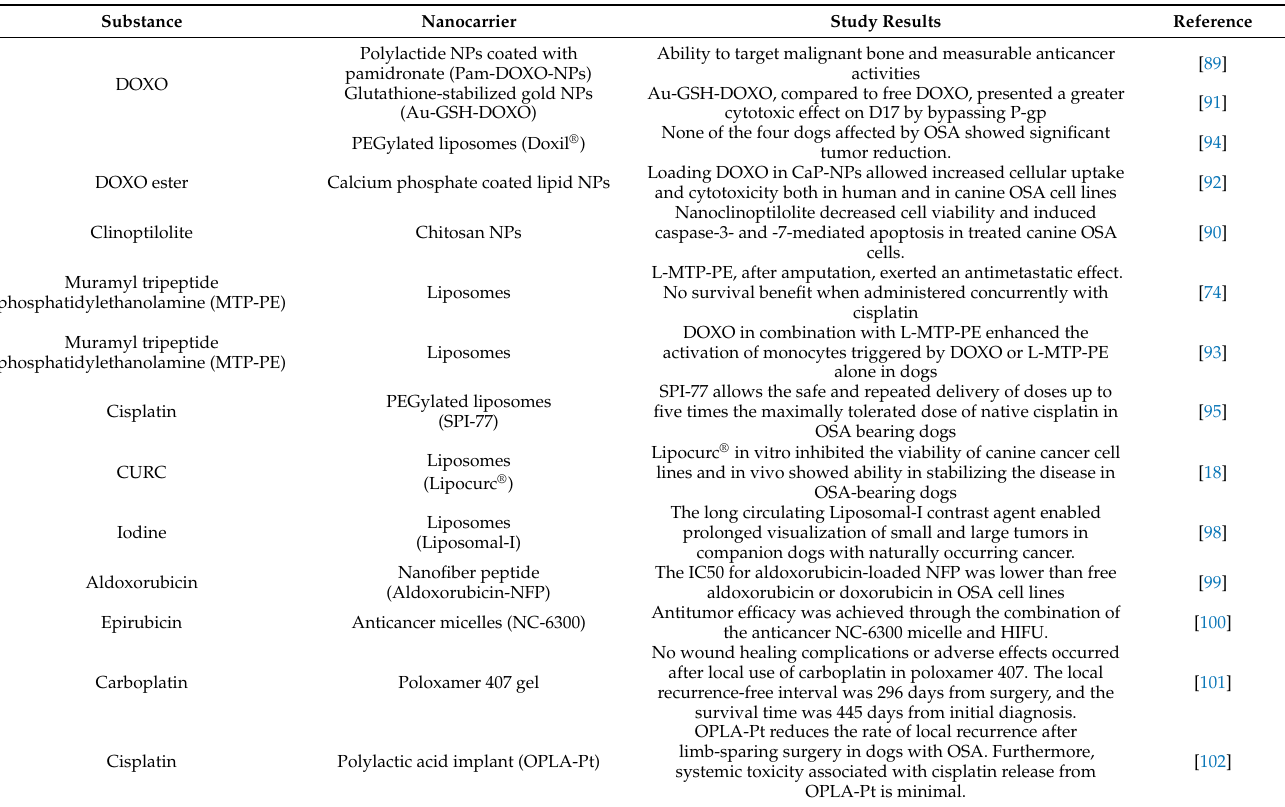
Table 2. Studies describing the use of nanocarriers in canine OSA